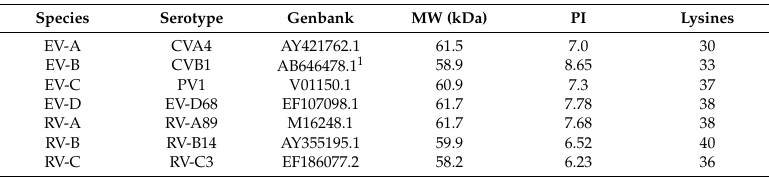
Table A1. Details on VP1